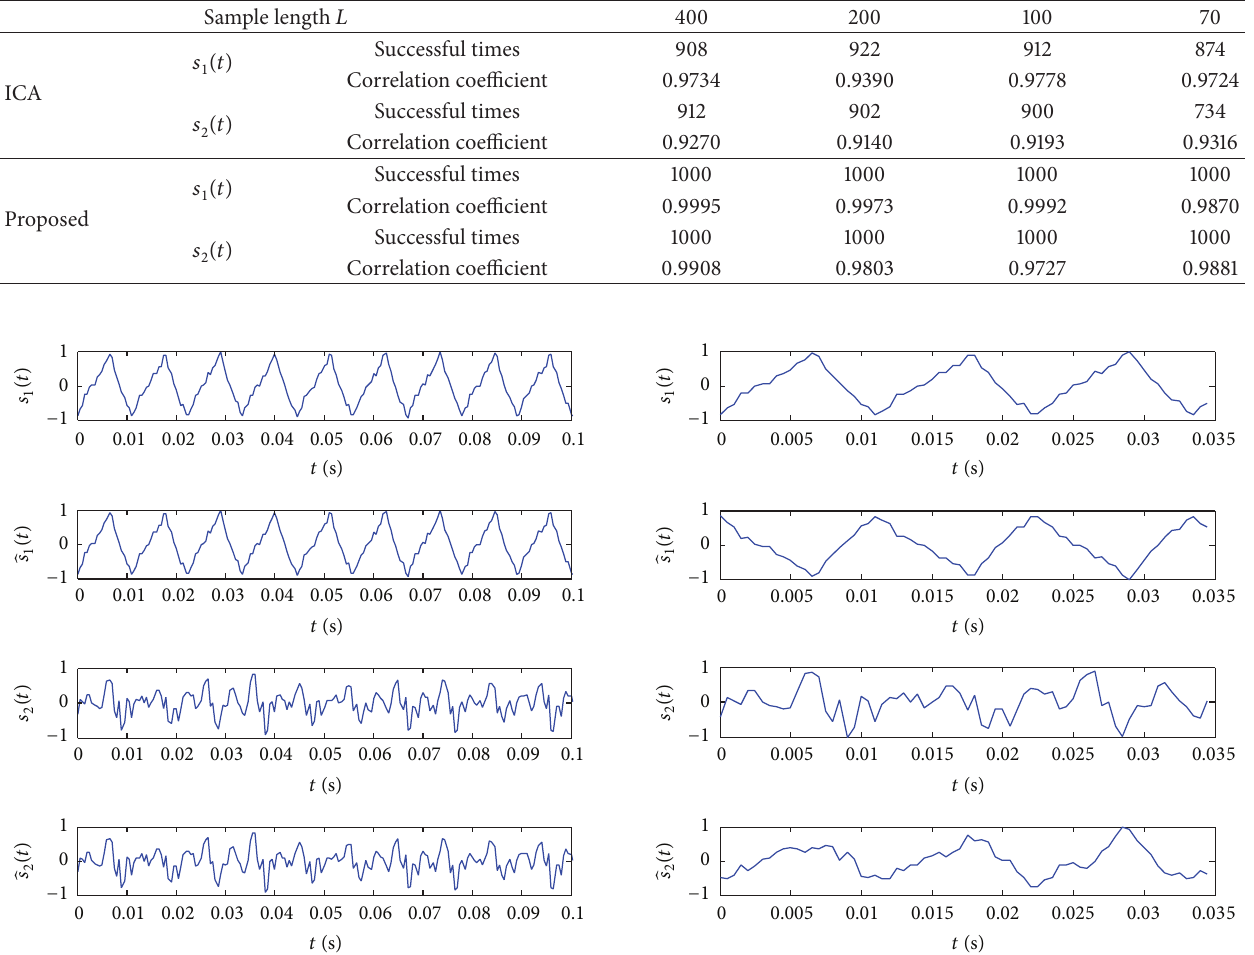
Table 2: The recovery correlation coefficients and successful times of numerical experiment.